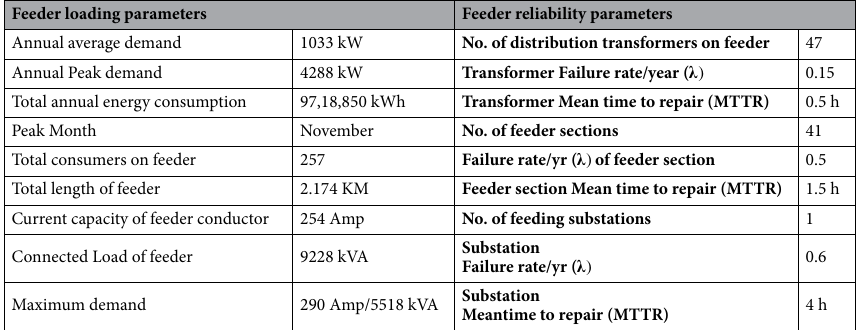
Table 1. Industrial feeder technical parameters.